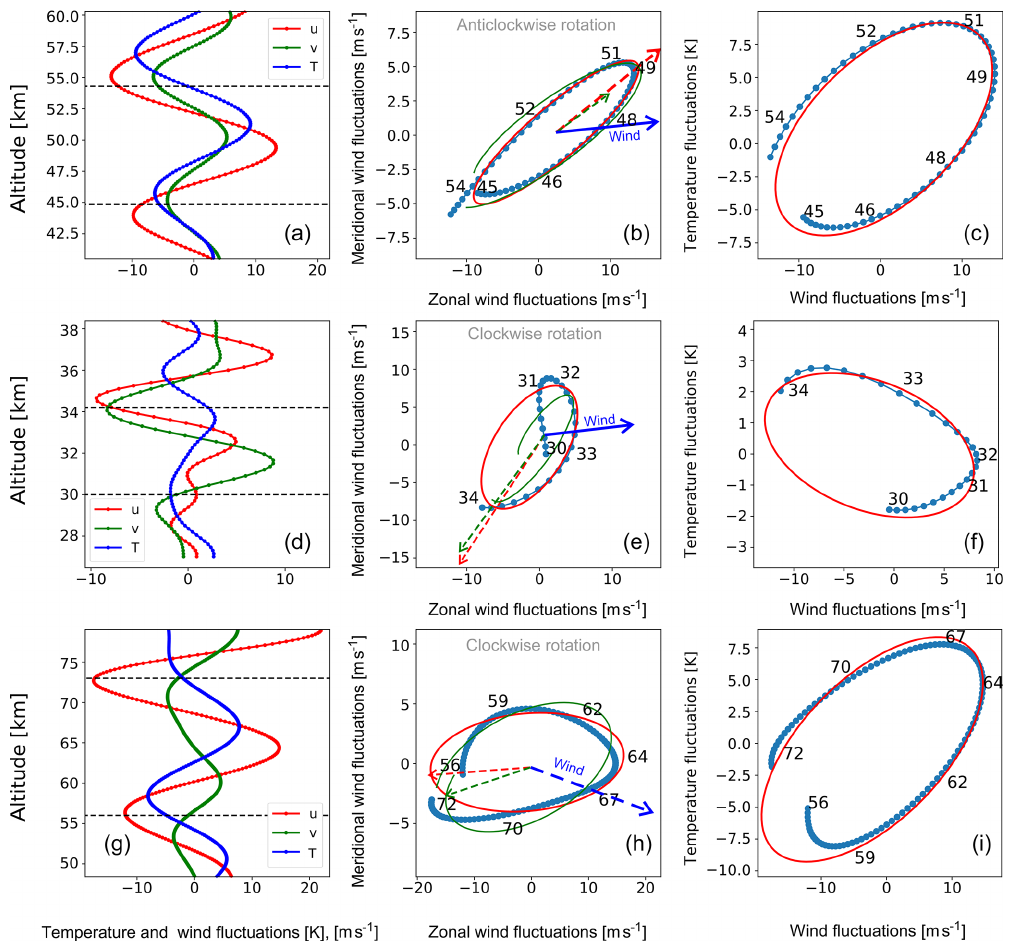
Figure 7. (a) , (d) and (g) are vertical profiles of observed fluctuations of both wind components and temperature observed at 02:07UT on 10 January 2016, and dashed lines mark the altitude range used for the hodographs. Hodographs of (b) , (e) and (h) are the zonal wind versus meridional wind fluctuations, and (c) , (f) and (i) are the parallel wind fluctuations ( u (cid:48) (cid:107) ) versus temperature fluctuations. Further quantities of the GW, and the background are listed in Table